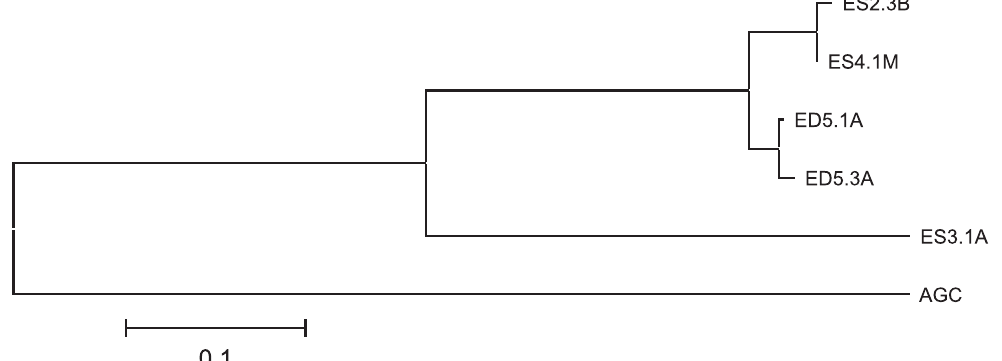
1.Figure 3. Clustering of Rhizoctonia -like fungi isolates based on rDNA sequences of the ITS region using the Neighbor-Joining method and distance matrix of the Kimura 2-parameter. Codes in the clusters correspond to the isolates presented in Table